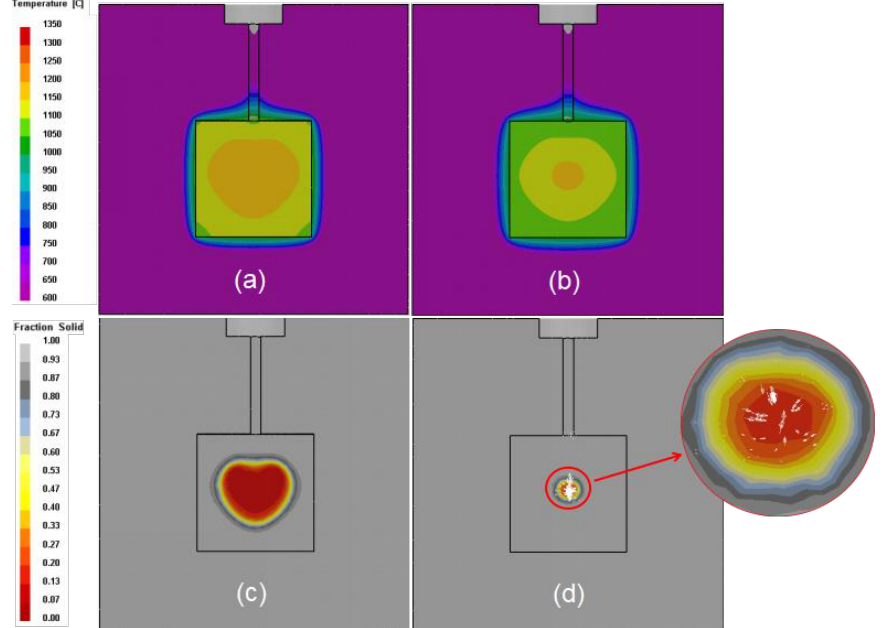
Figure 6. Solidification progress and riser top state of prototype C3 poured at 1250 °C: ( a ) Casting temperature decreased during solidification; ( b ) Casting temperature filed at the end of solidification; ( c ) Solid fraction distribution during solidification; ( d ) Flow field in mushy zone at the end of solidification.